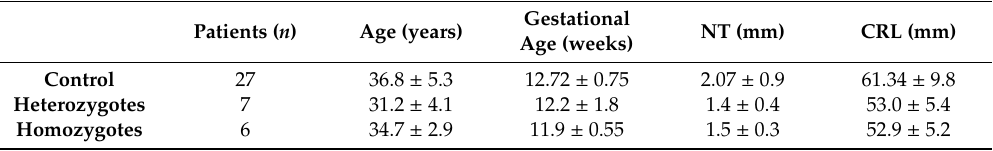
Table 1. Data of the patients enrolled in the study. (Average maternal age, gestational age, nuchal translucency, and crown-rump